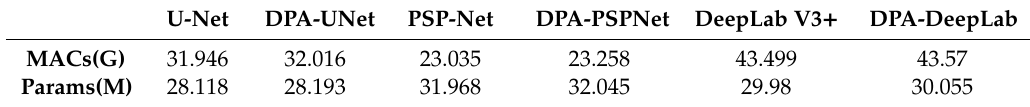
Table 11. Multiplication and Accumulation (MAC) results and number of parameters for di ff erent